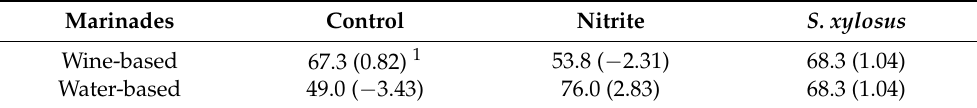
Table 3. Consumption intention of cured loins. Results are presented as a percentage of consumers and the standardized residuals.